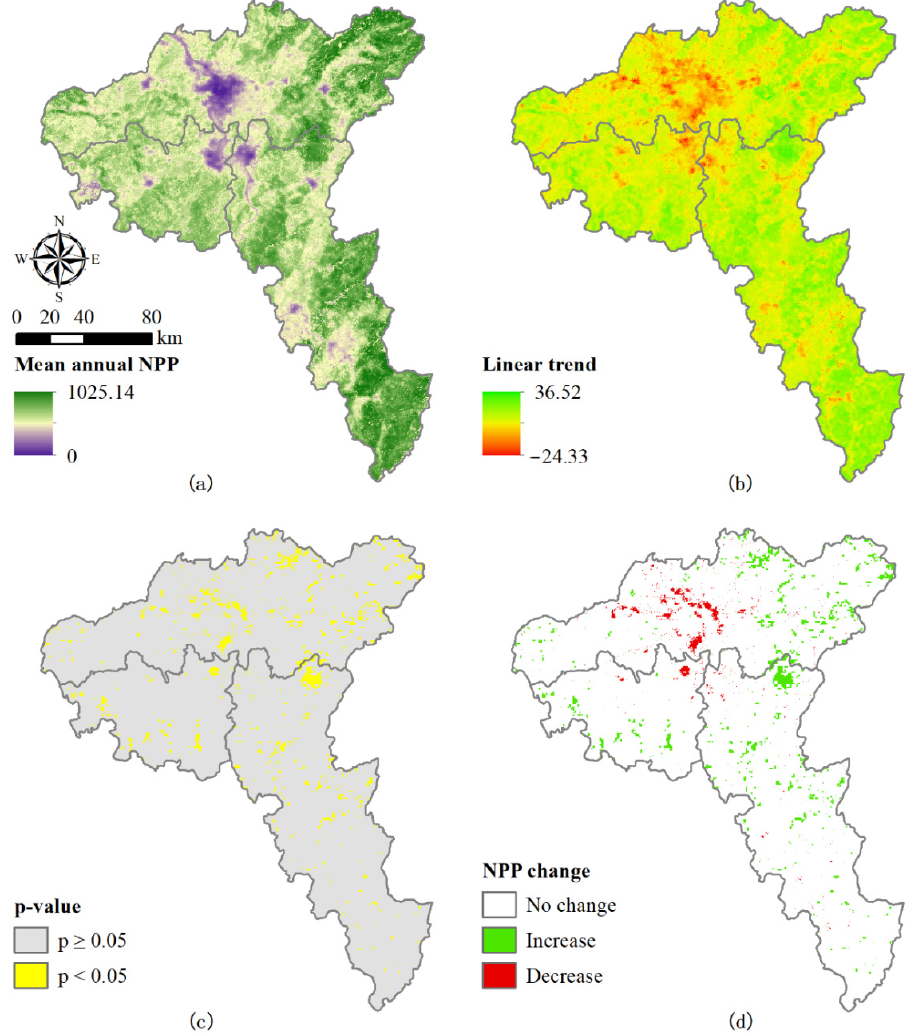
Figure 3. Spatiotemporal variations in annual NPP (gC•m − 2 ) in the CZT urban agglomeration at the pixel level between 2000 and 2015. ( a ) Average annual NPP; ( b ) change trends of annual NPP (gC•m − 2 ); ( c ) p -value of the t-test for the modeled slopes; ( d ) the NPP change types. Note: The least-square linear regression model was applied to analyze the temporal variation in annual NPP between 2000 and 2015 for each pixel. The changing trend is described by the modeled slope in ( b ). In ( d ), “No change” documents that the annual NPP did not change (a = 0 and p ≤ 0.05) or did change, but not significantly (a ≠ 0 and p > 0.05).